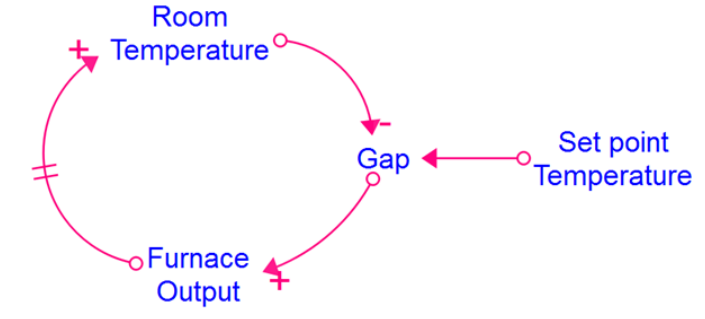
Fig. 1. Temperature control causal loop